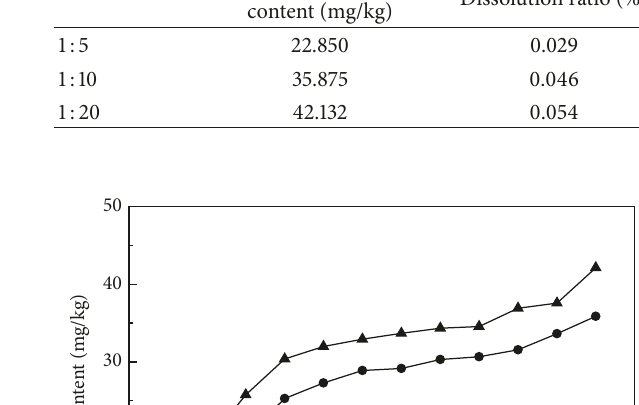
Figure 3: Effect of solid-to-liquid ratio on Sb release characteristic of smelting slag in static immersion test.